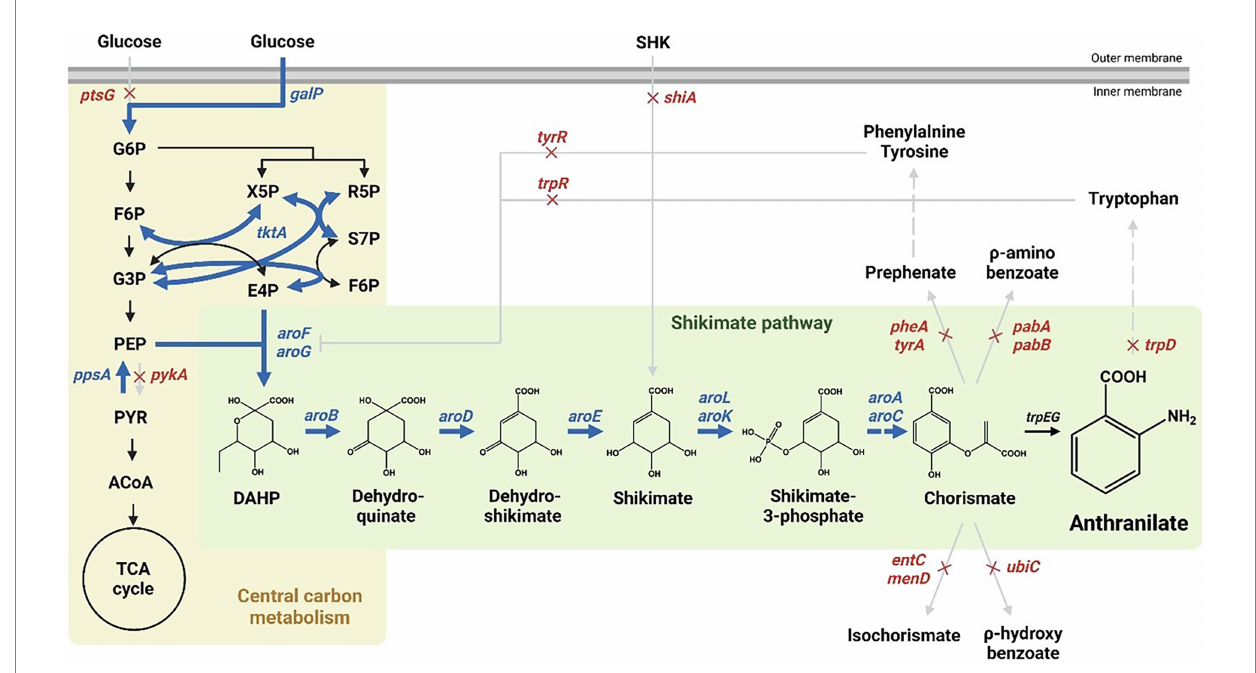
FIGURE 1 Scheme of the pathway engineering for anthranilate production in Escherichia coli . Red crosses indicate disrupted genes and bold blue arrows indicate enhanced steps through target gene overexpression. Dashed arrows represent two or more steps. G6P; glucose-6-phosphate, F6P; fructose-6-phosphate, G3P; glyceraldehyde-3-phosphate, PEP; phosphoenolpyruvate, PYR; pyruvate, ACoA; acetyl-CoA, X5P; xylulose-5-phosphate, R5P; ribose-5-phosphate, S7P; sedoheptulose-7-phosphate, E4P; erythrose-4-phosphate, F6P; fructose-6-phosphate, DAHP;